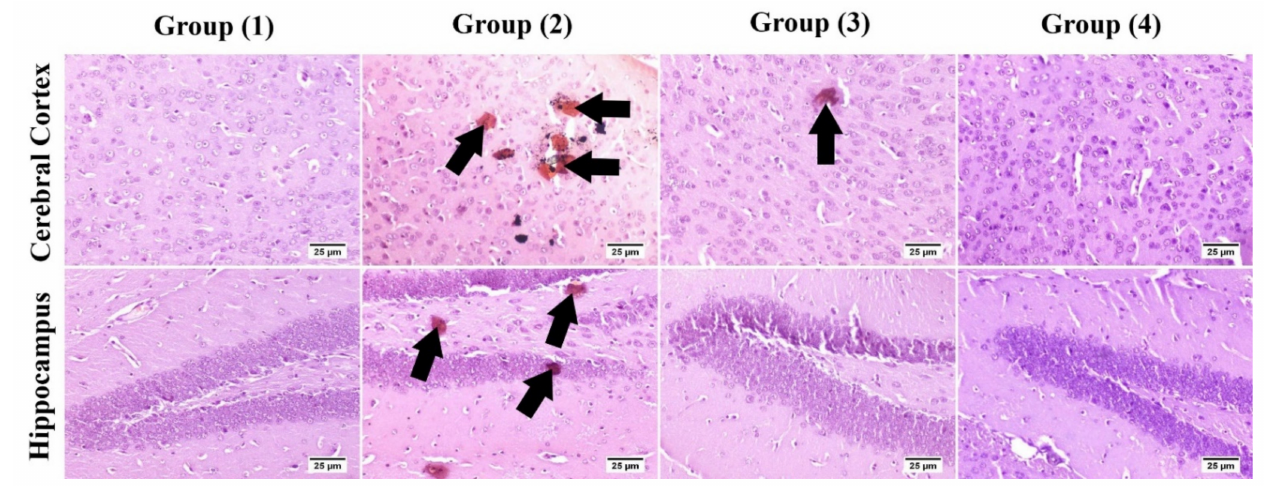
Figure 8. Photomicrograph of brain, Congo red for amyloid plaques visualization in the cerebral cortex and hippocampus. Group (2) showed marked increase in the number of amyloid lesions with few to absence in the treated groups (arrows).